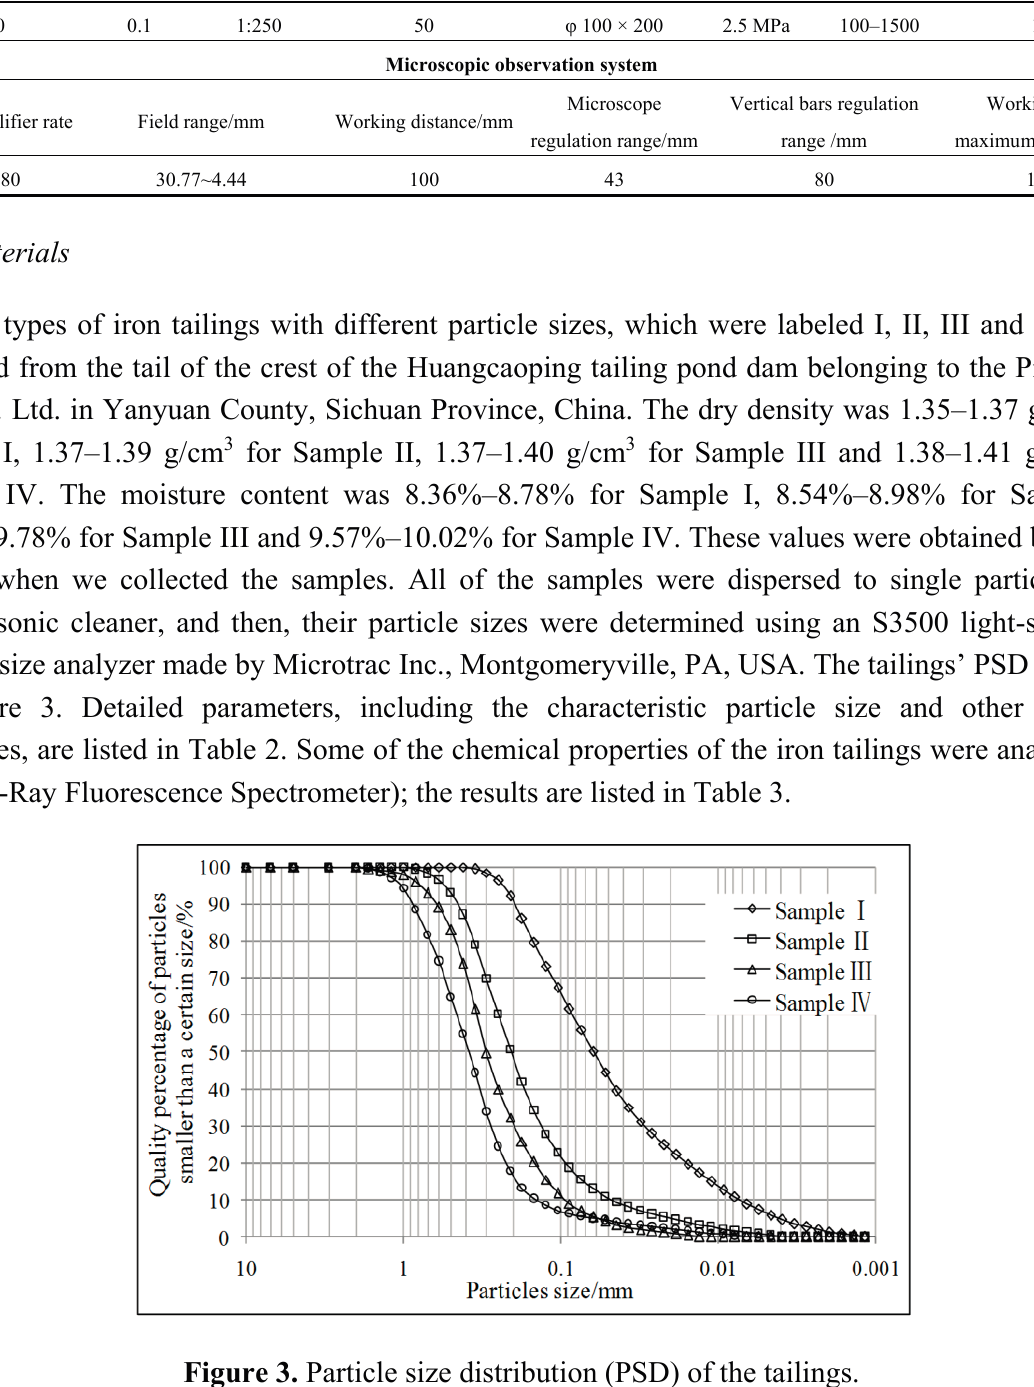
Figure 3. Particle size distribution (PSD) of the